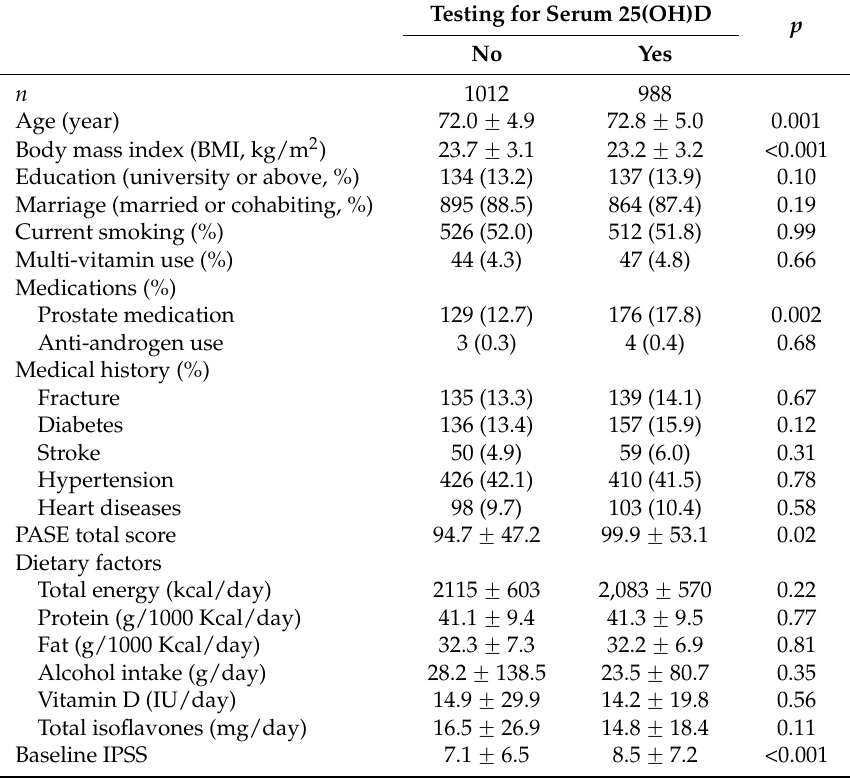
Table 2. Participants’ characteristics by with and without testing of serum 25(OH)D at